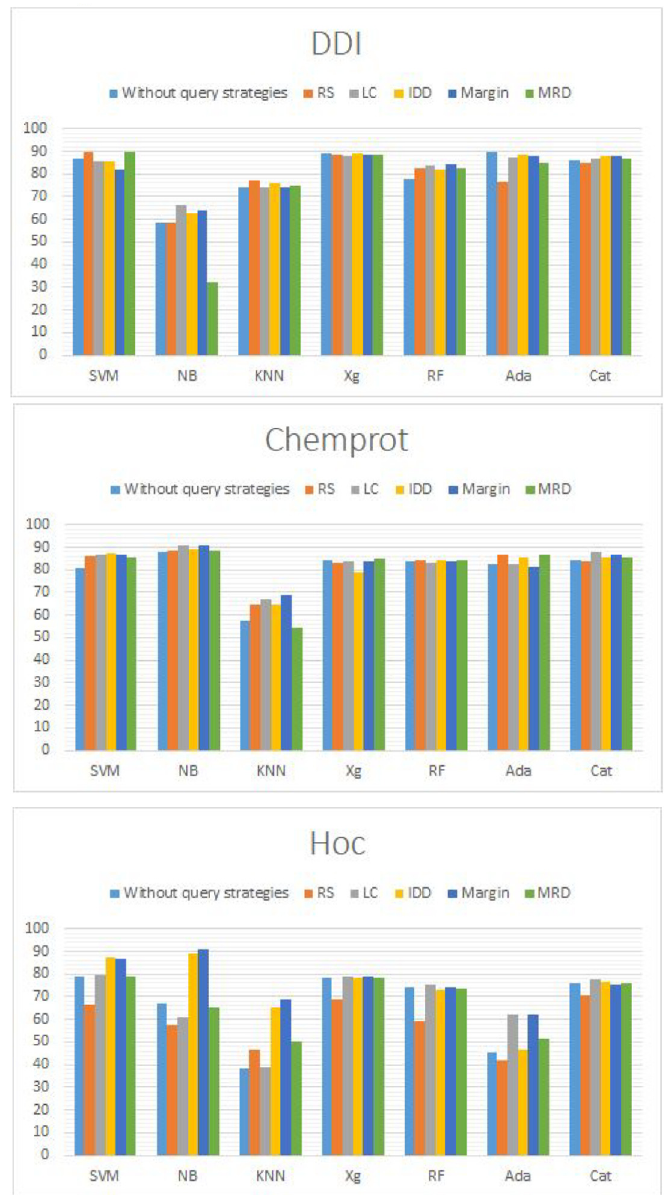
Figure 4. Graphical Representation of Results.